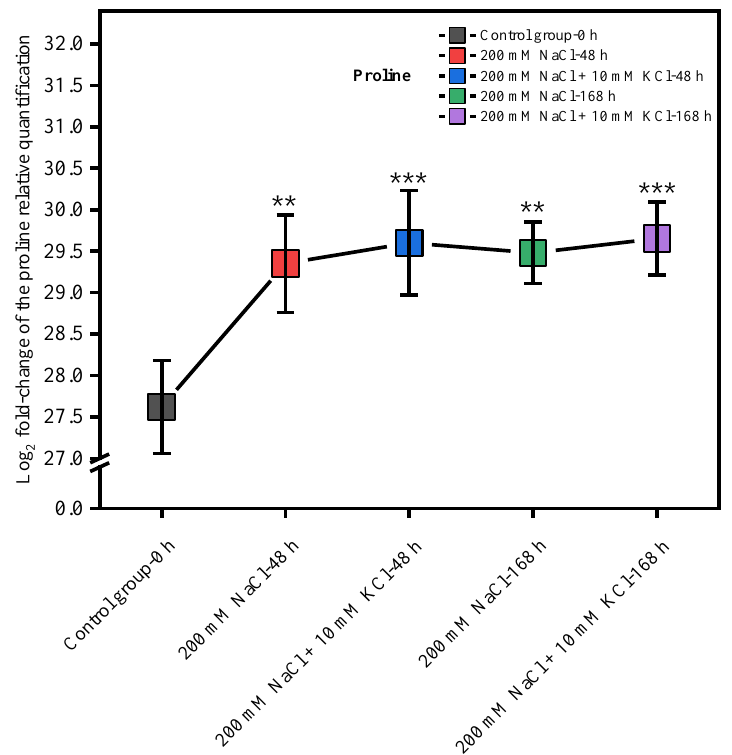
Figure 1. Log 2 fold-change of proline’s relative quantification in the T. ramosissima roots under different treatments (Log 2 fold-change of proline’s relative quantification in the roots of T. ramosissima under 200 mM NaCl + 10 mM KCl and 200 mM NaCl treatments. Note: p ≥ 0.05 is not marked; ** 0.001 < p < 0.01; *** p ≤ 0.001).